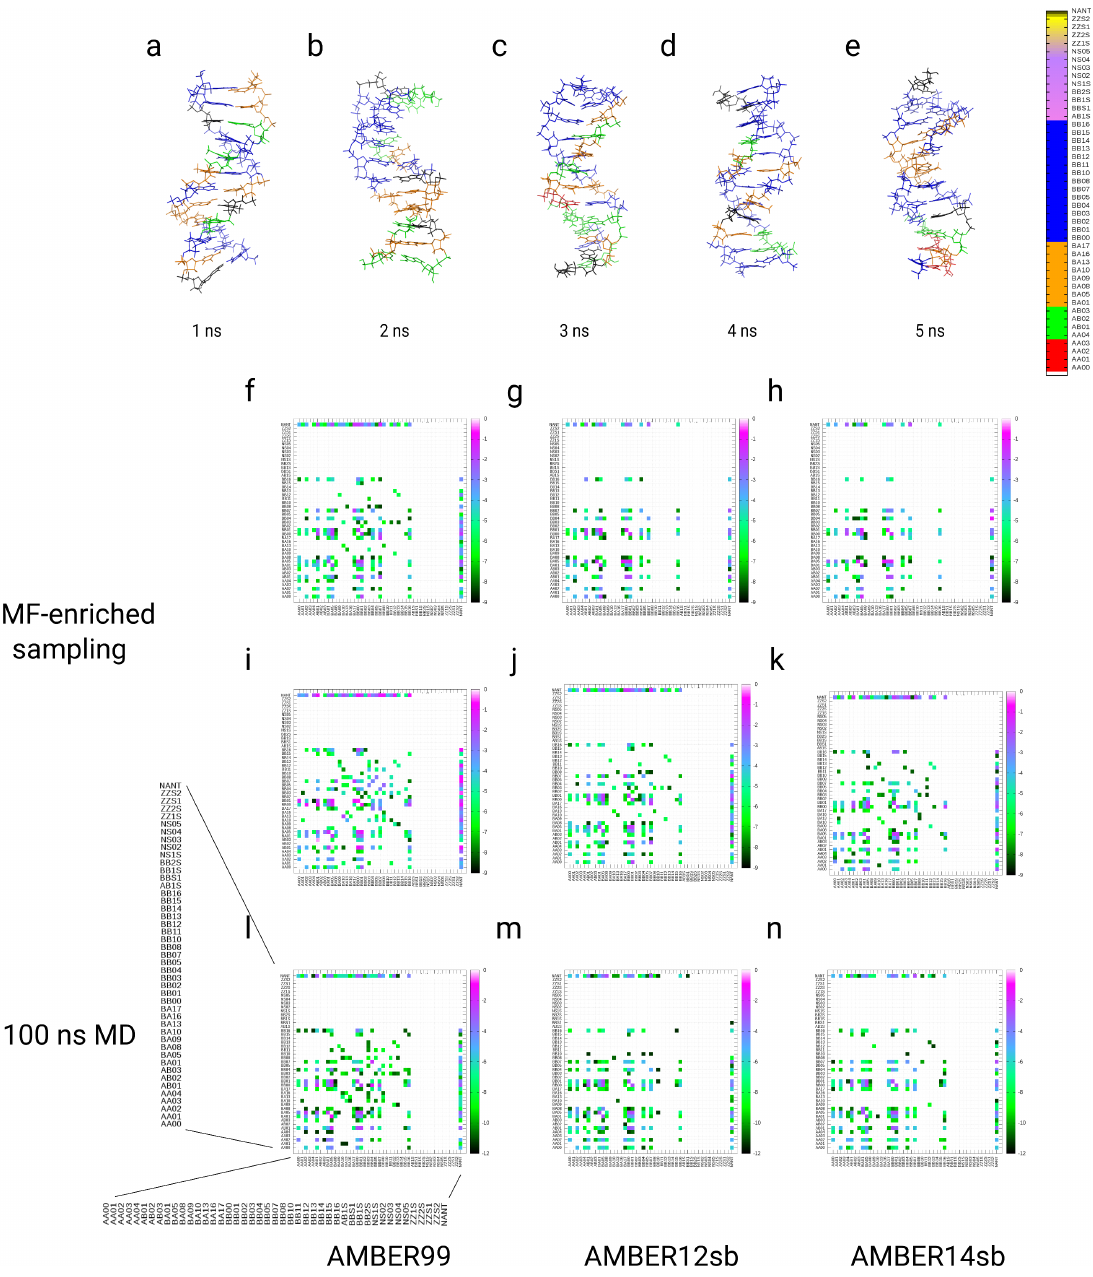
Figure 7. ( a – e ) Conformers of the Dickerson–Drew DNA dodecamer along the enhanced sampling trajectory over 5 ns using the AMBER12sb force field (with a coupling factor α = 10 − 9 ). Conformers are color-indexed depending on their assignment to the 44 different NtC classes from the structural alphabet. The colored bar represents the structural classes shown on the right side. ( f – k ) Results from the kinetic analysis of the frequencies ln ν , ν = 1/ τ of the transition time between different structural classes (in the order from class n shown on the x-axis to classes n’ on the y-axis) as a function of 44 different NtC classes in the PMF-enriched ( f – k ) and 100 ns MD simulations ( l – n ) (class #45 represents the non-assigned class)) (using the two different α coupling factors: 10 − 9 ( f – h ) and 10 − 8 ( i – k )). We compared the three simulations with different force fields: AMBER99 ( f , i , l ), AMBER12sb ( g , j , m ), and AMBER14sb ( h , k , n